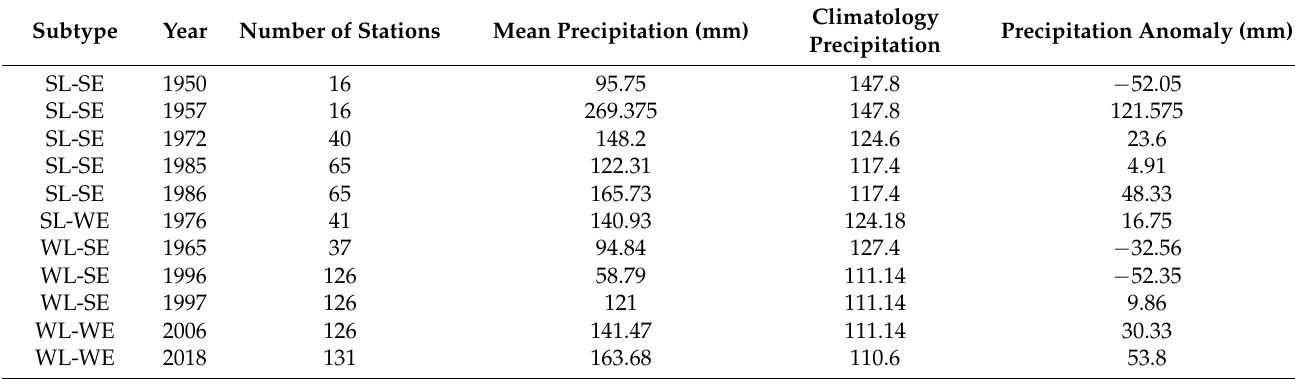
Table 3. Autumn precipitation values for all cases of ENSO transition type 2